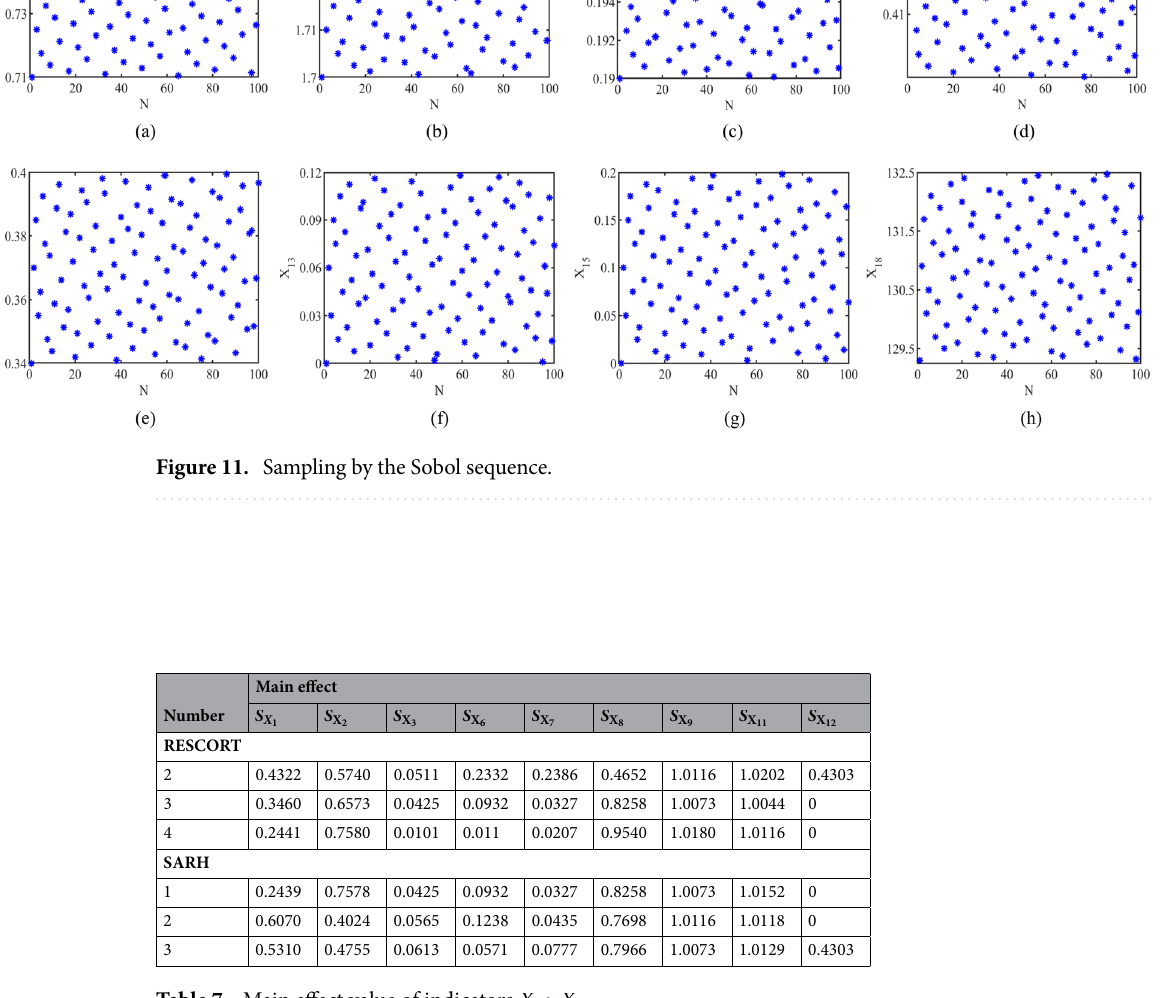
Table 7. Main effect value of indicators X 1 ∼ X 12